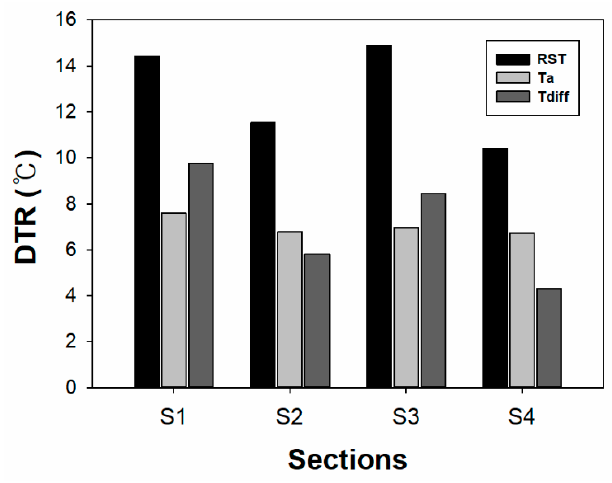
Figure 11. Diurnal temperature ranges (DTRs) of road-surface temperature (RST), air temperature (Ta) and temperature difference (Tdiff) for different sections.